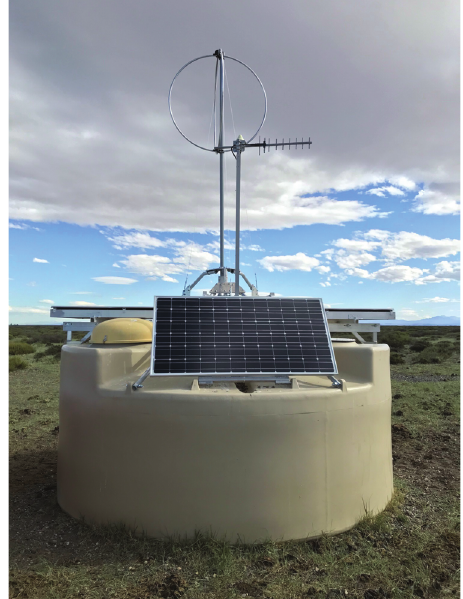
Figure 1. Photo of a prototype RD station in the field. The dual- polarized SALLA antenna is mounted on a fiberglass mast held in place by an aluminum frame, which is connected directly to the WCD tank. Guy wires help suppress vibrations. The addi- tional RD readout electronics is encapsulated in the dome visible in the